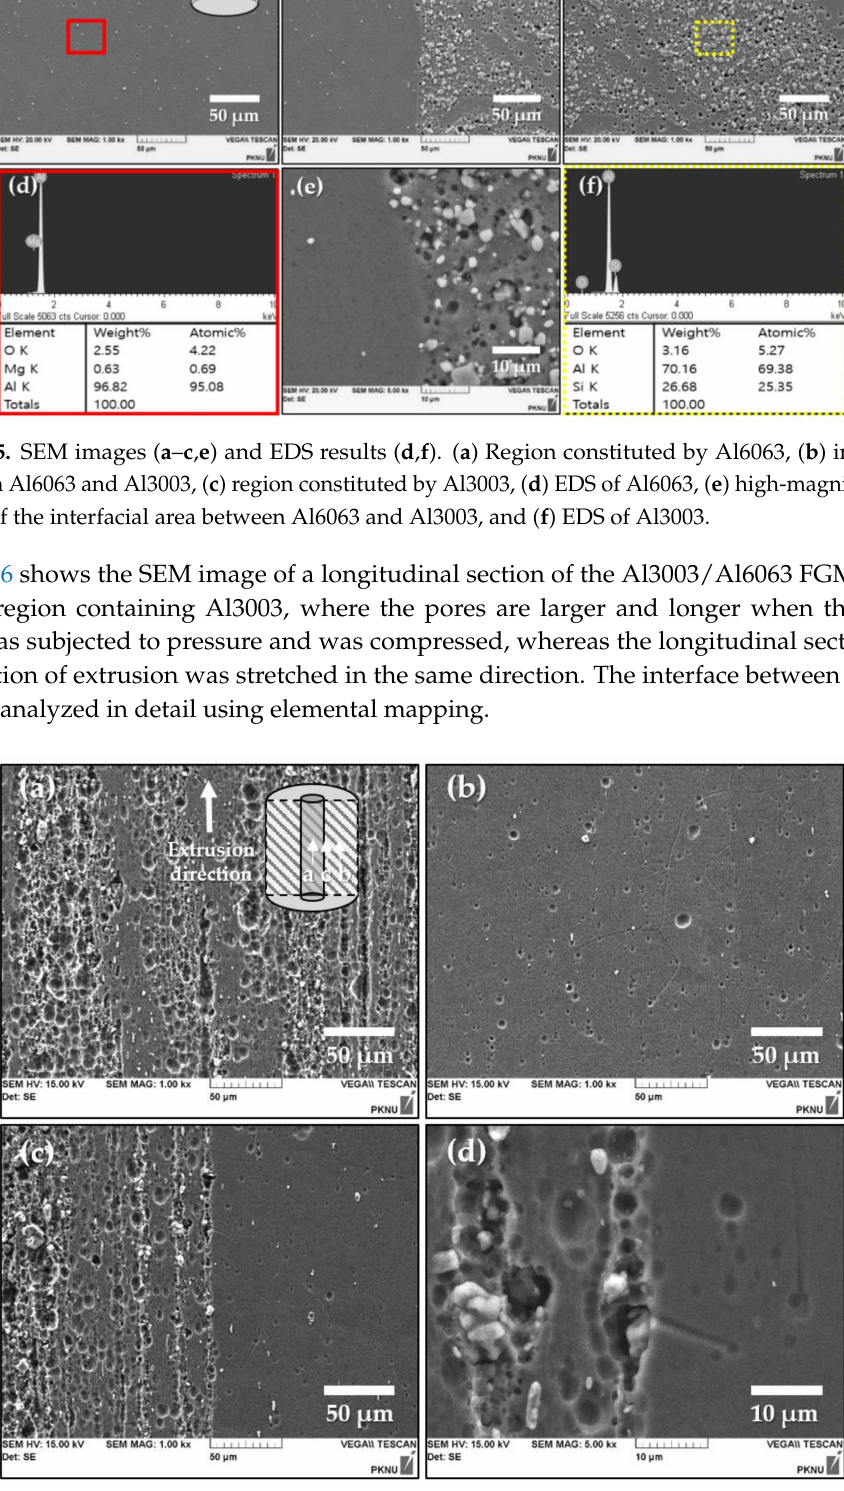
Figure 6. SEM images of the longitudinal section of the FGM. ( a ) Region containing Al3003, ( b ) region containing Al6063, ( c ) interface between Al3003 and Al6063, and ( d ) high-magnification image of the interface between Al3003 and